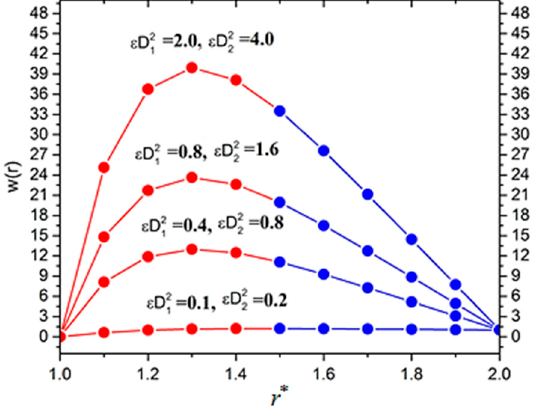
= 5, ε D 2 = 10, δ = 2. 2 1